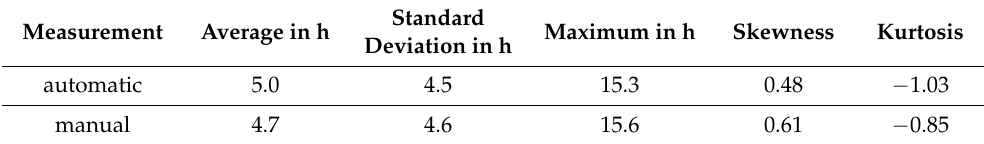
Table 2. Selected statistics of daily sunshine duration in Borucino, 2015–2021. Measurement Average in h